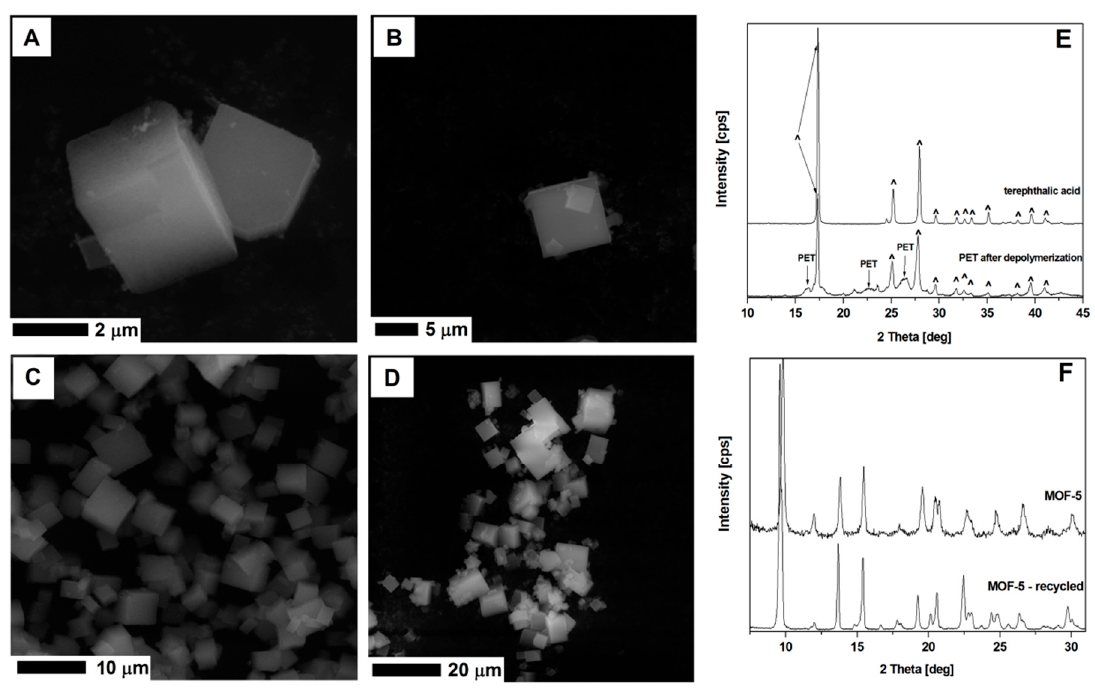
Figure 15. The SEM images of MOF-5 synthesized from fresh substrates ( A , B ), recycled DMF and terephthalic acid ( C , D ). The XRD spectrum of the terephthalic acid and depolymerized PET ( E ), and MOF-5 from unreacted and recycled substrates ( F ).